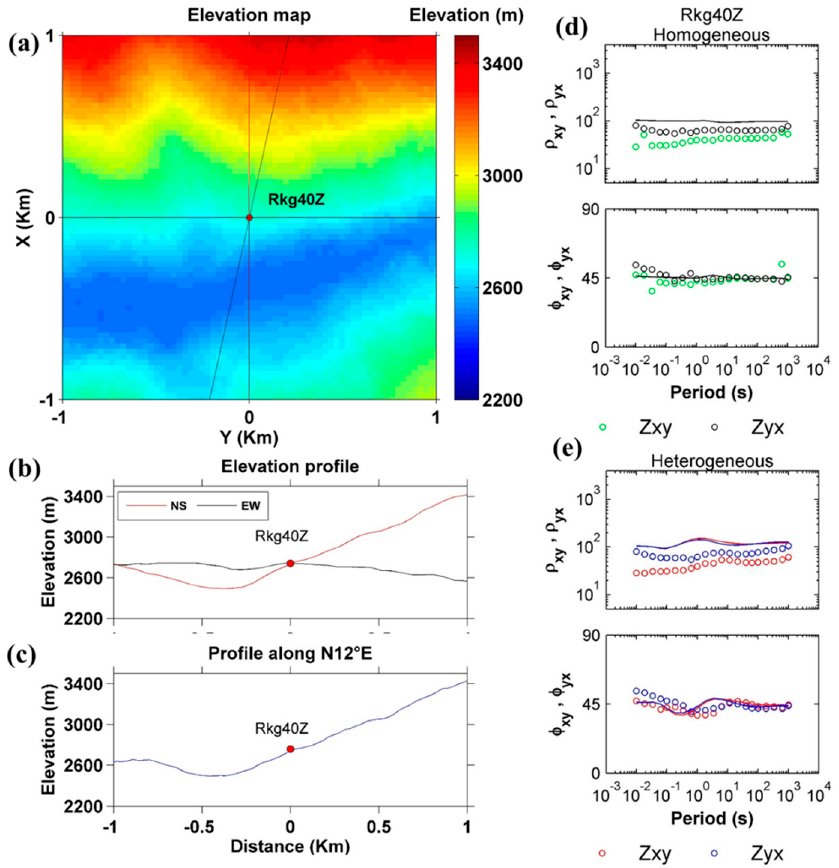
Figure 12. ( a ) The elevation map around site 40. ( b ) Elevation profile along the NS, EW and the direction of maximum elevation change ( c ). ( d ) The comparison of MT response of off-diagonal components generated by ( d ) homogeneous half-space model and ( e ) heterogeneous model.